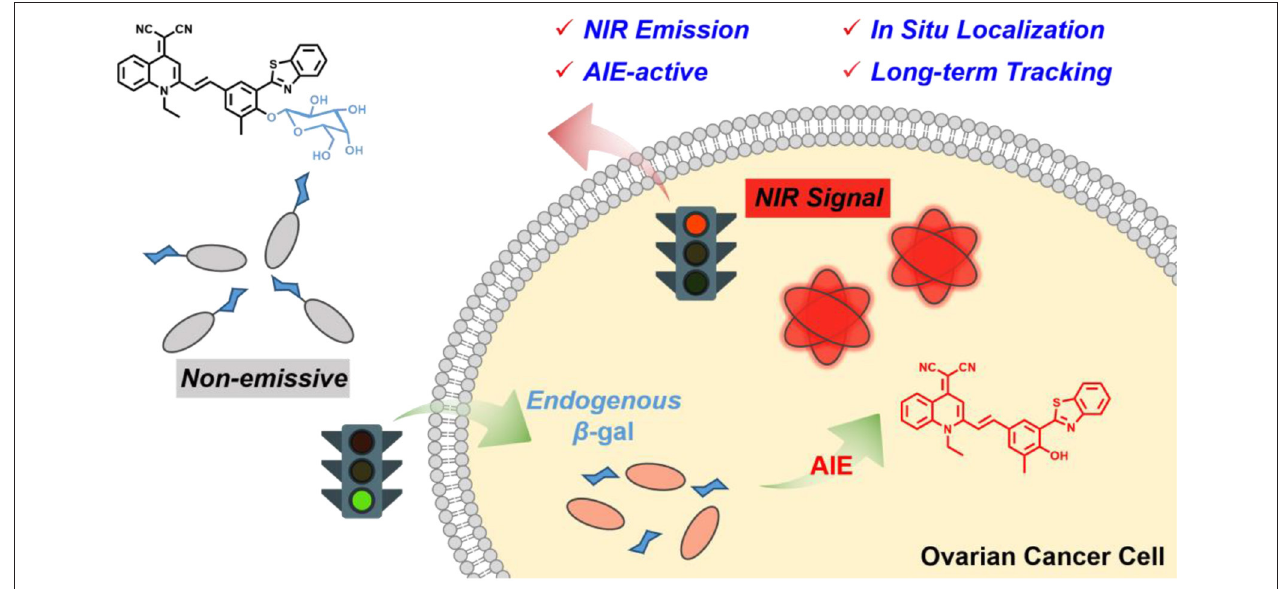
FIGURE 1 | Spectral properties of QM-HBT- β gal and QM-HBT-OH with different water fractions ( f w ) in a mixture of water/tetrahydrofuran. (A) Absorption spectra, (B) emission spectra, and (C) I / I 0 plots of QM-HBT- β gal (10 µ M); (D) absorption spectra, (E) emission spectra, and (F) I / I 0 plots of QM-HBT-OH (10 µ M), where I is the fluorescence intensity at 620nm and I 0 is the fluorescence intensity of QM-HBT- β gal or QM-HBT-OH in 0% water, λ ex = 460nm.